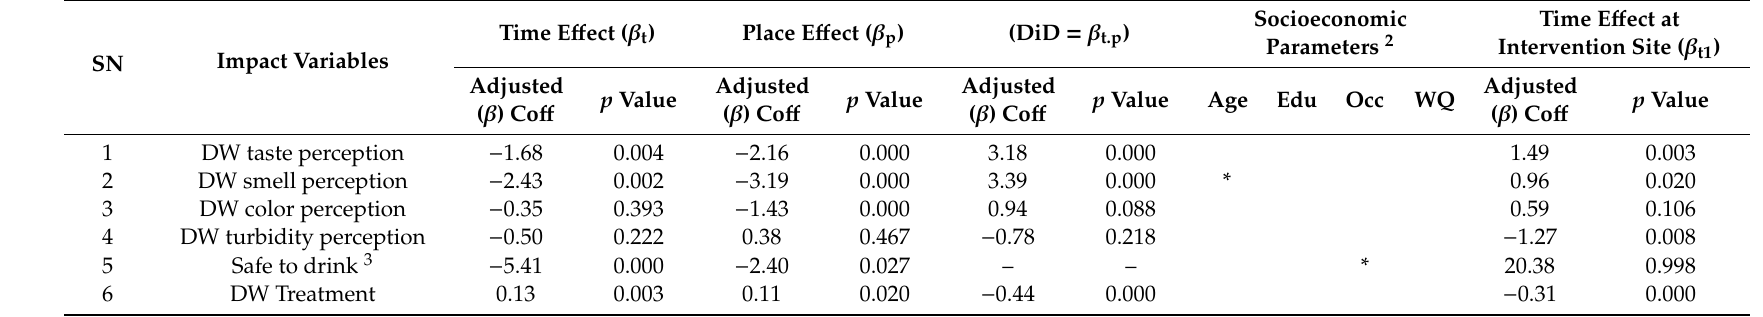
Table 4. Statistical evaluation of the impact of LCD-treated water distribution on binary impact variables 1 .